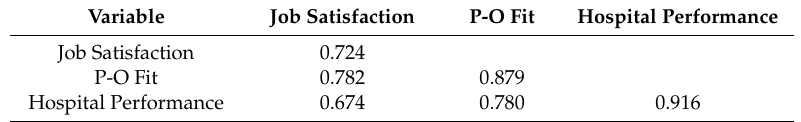
Table 3. Square root of AVE and Pearson correlation coe ffi cients of measurement